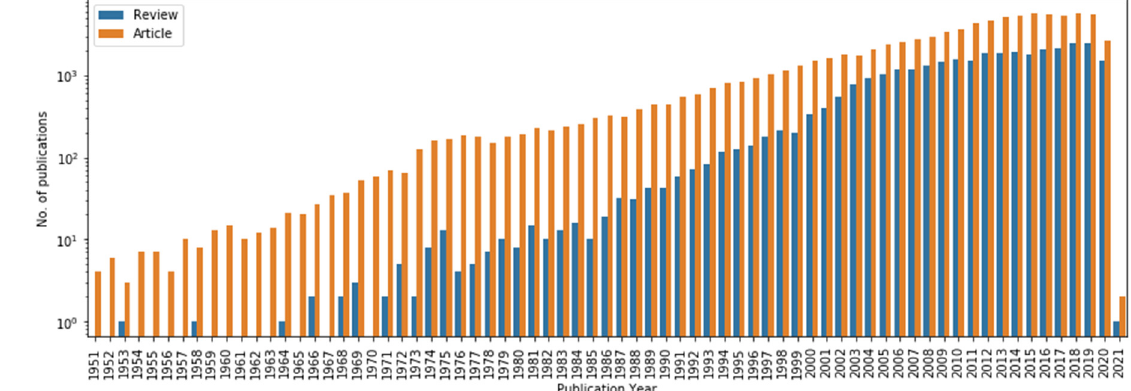
Figure 1. Above: Distribution of Articles ( orange ) and Reviews ( blue ) included in the present corpus, expressed on a log scale.